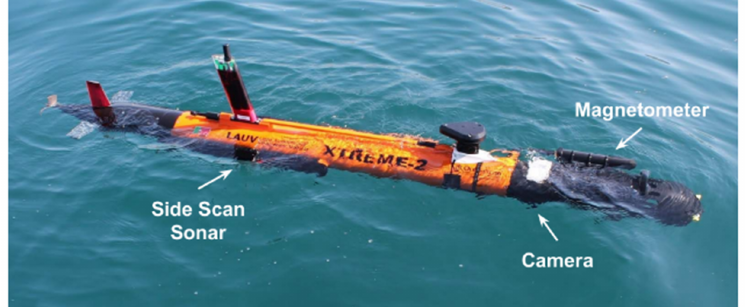
Figure 14. LAUV-Xtreme-2 AUV integrated with Side-scan Sonar, Underwater Camera and Magne- tometer [140].